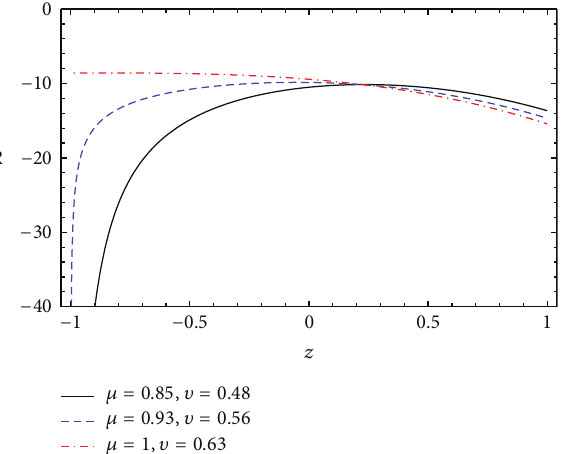
Figure 9: Reconstructed 𝑓(𝑅) in (a) 𝑓−𝑅 plane and (b) 𝑙𝑓−𝑙𝑅 plane for NHDE with 0 ⩽ 𝑧 ⩽ 10 .